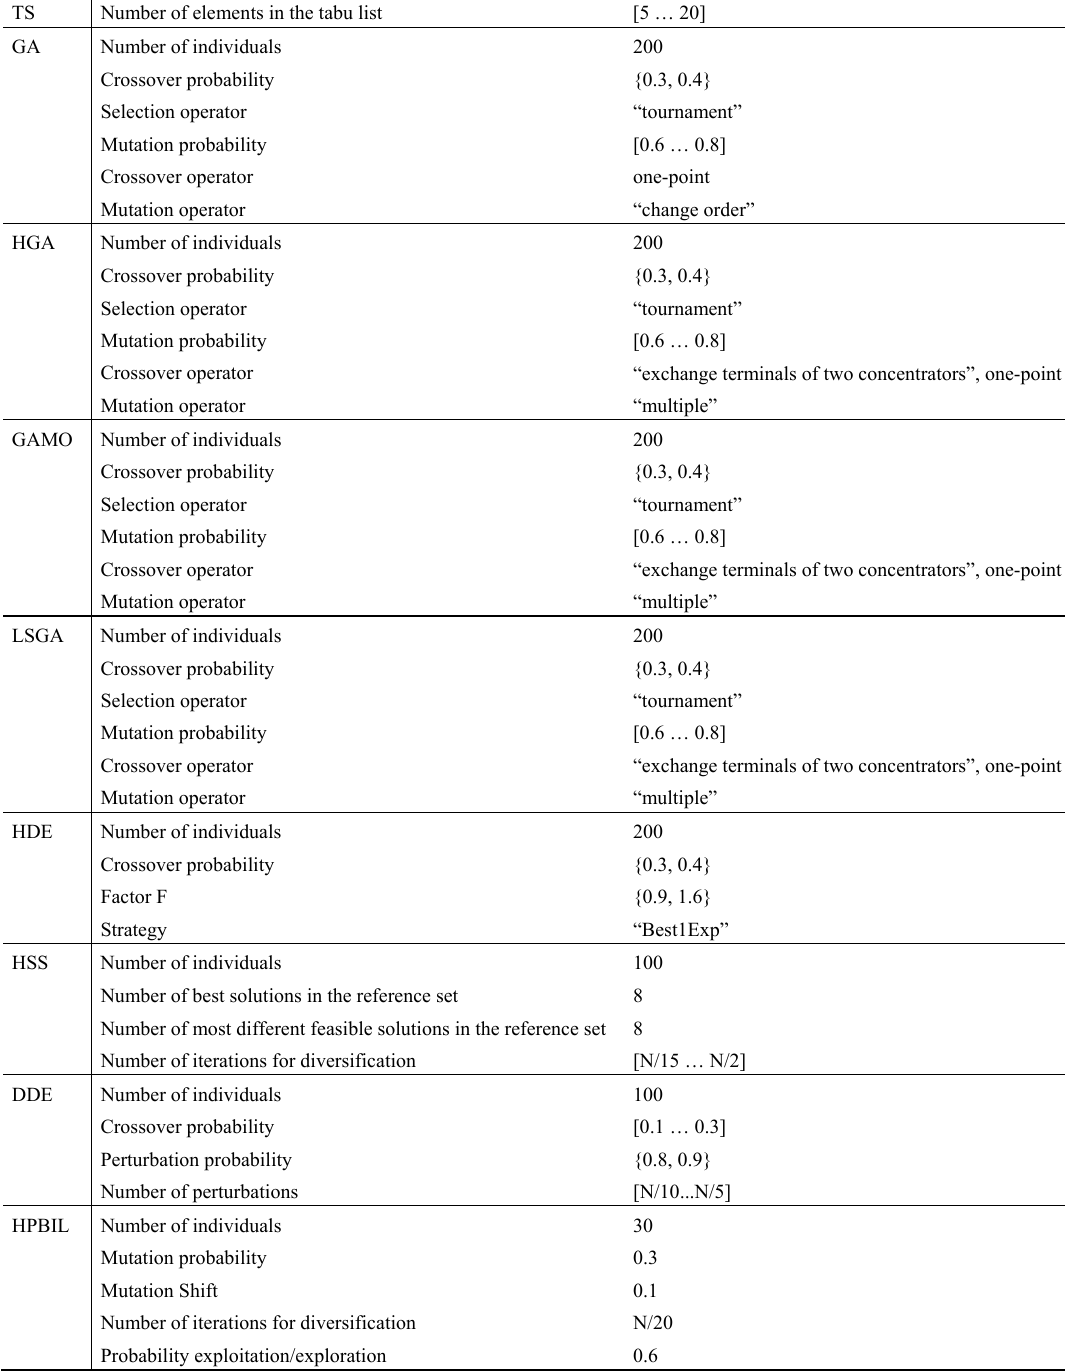
Table 2. Parameter